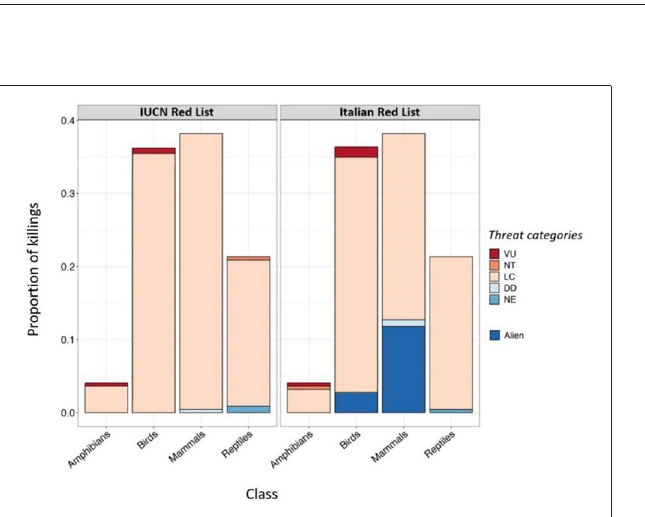
FIGURE 4 | Proportions of species killed by cats, grouped by threat categories. The two panels show different groupings according to the IUCN and Italian Red List species classifications. Legend codes indicate threat categories: VU, Vulnerable; NT, Near Threatened; LC, Least Concern; DD, Data Deficient; and NE, Not Evaluated. Alien species (i.e., those introduced to Italy) were not classified according to the Red List categories.